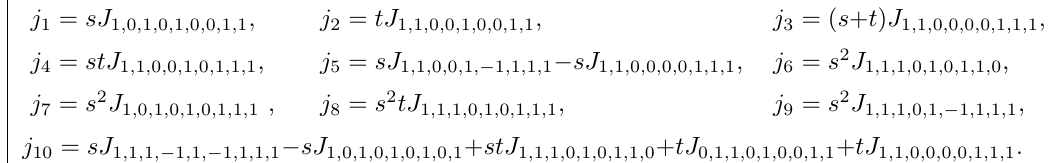
Table 1 . Planar double box integrands with constant leading singularities. Integrands that can be obtained from (cid:13)ip symmetries are not